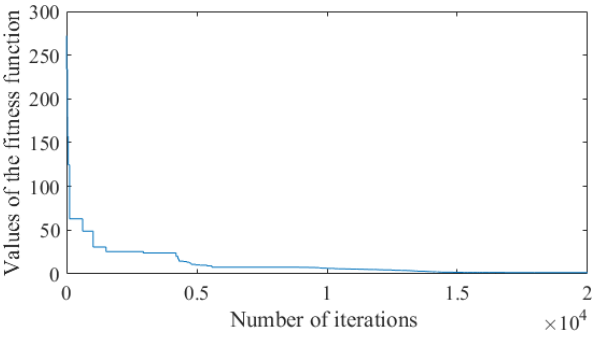
Figure 8. The relationship between number of iteration and fitness function.